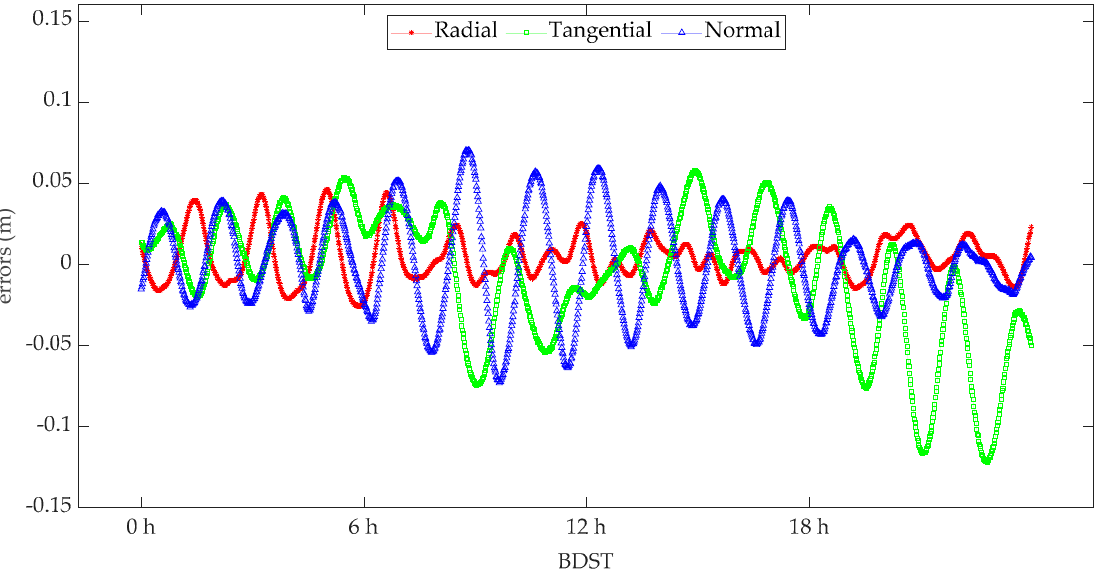
Figure 6. The variation in errors for the HY2D satellite using spaceborne BDS data compared with CNES orbit.